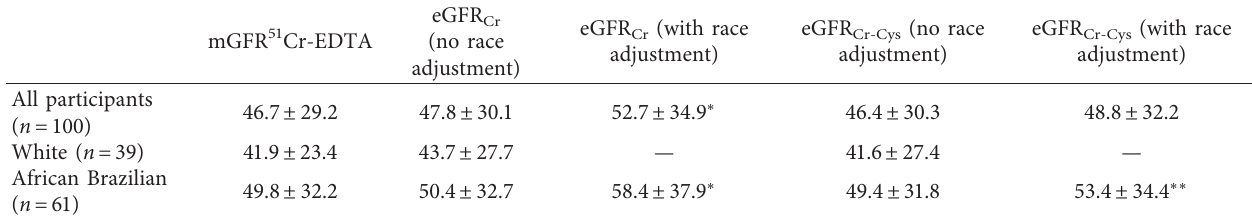
Table 3: Measured and estimated GFR by CKD-EPI equations, with and without race adjustment.